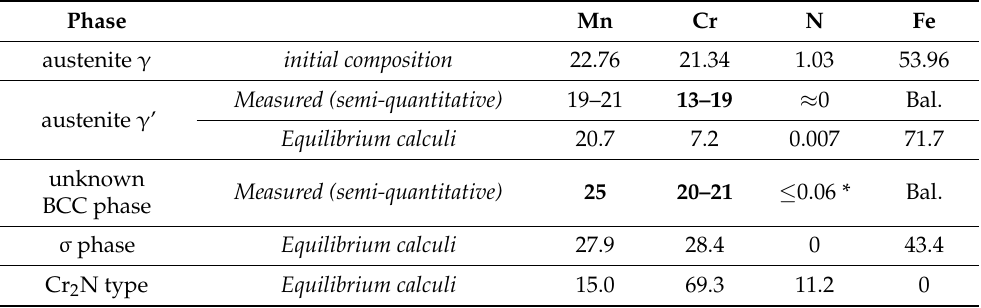
Table 3. Concentrations (wt%) of the main chemical elements in the different phases and comparison with equilibrium composition. In bold are the measured data having discrepancies with the equilib- rium compositions. The value with (*) has been measured in a SEM with a wavelength dispersive X-ray analysis (WDX), using a LSM80E Ni–C crystal, at 5 kV in order to reduce the interaction volume. Phase